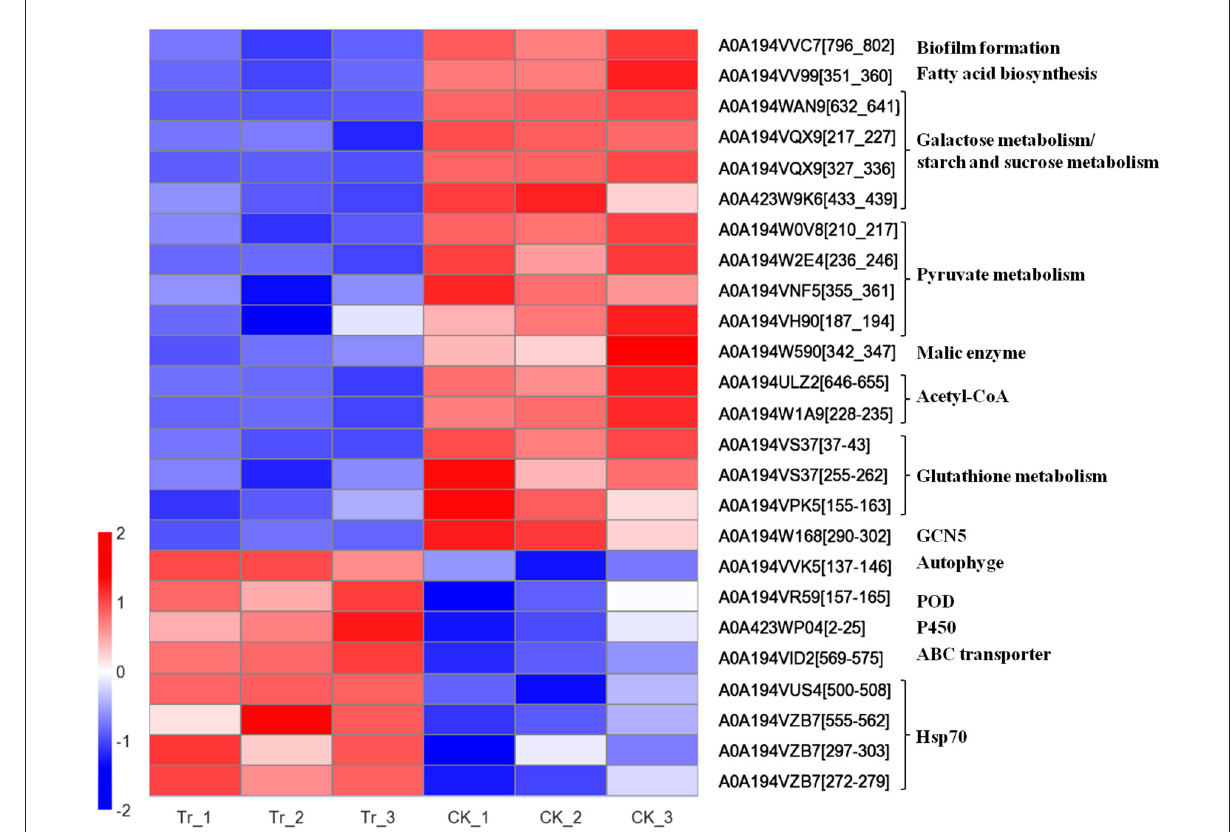
FIGURE5 Heatmap of expression level of acetylated proteins involved in the growth and pathogenicity of C. mali QH2 , and its response to B. velezensis